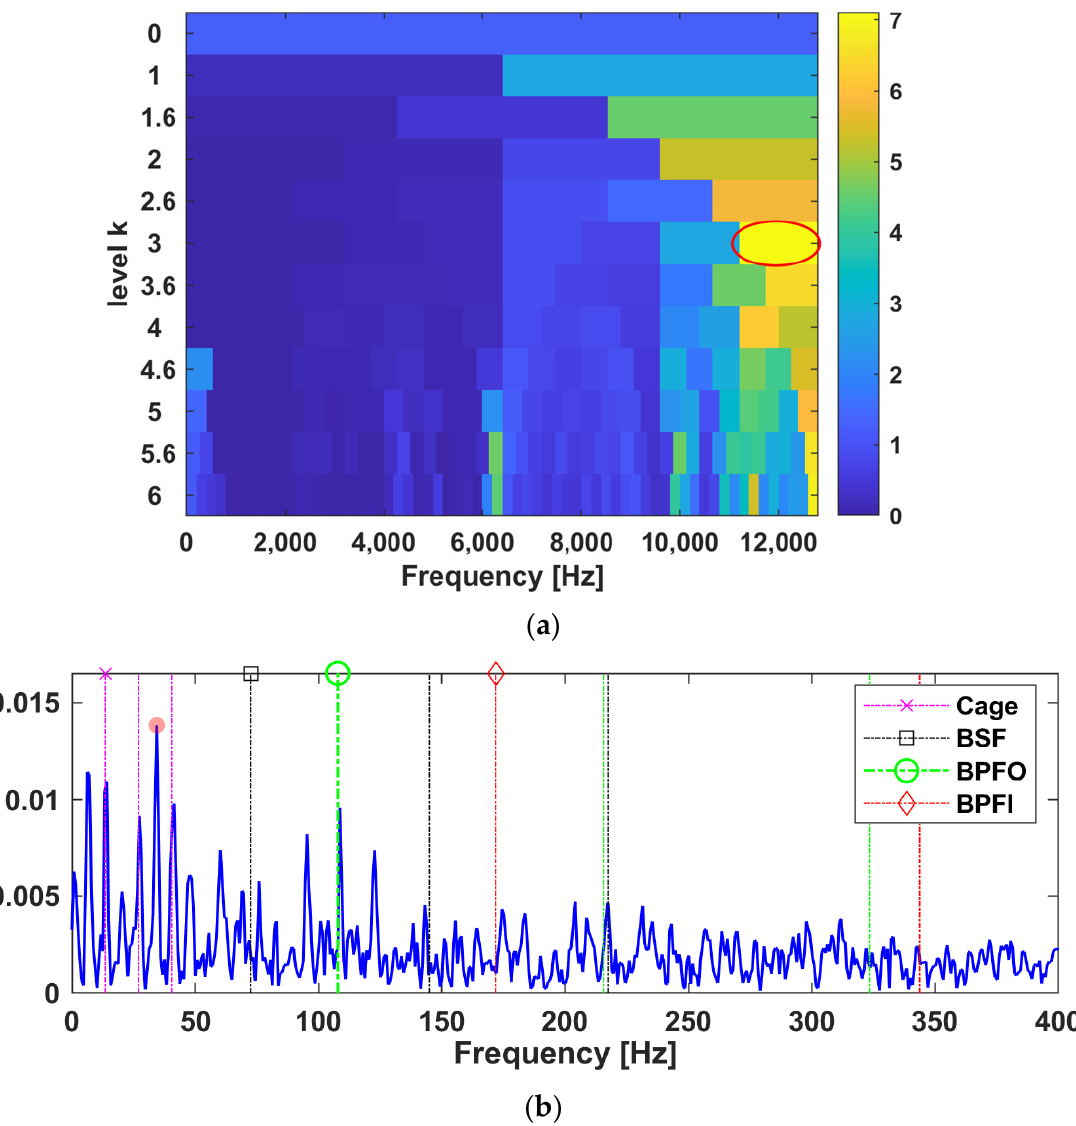
Figure 17. Results of Fast Kurtogram: ( a ) Kurtogram with the maximum kurtosis, 7.1, found at level 3, with band width 1600 Hz, and the central frequency at 12,000 Hz. ( b ) The envelope spectrum of the filtered signal using the aforementioned optimal filter band.